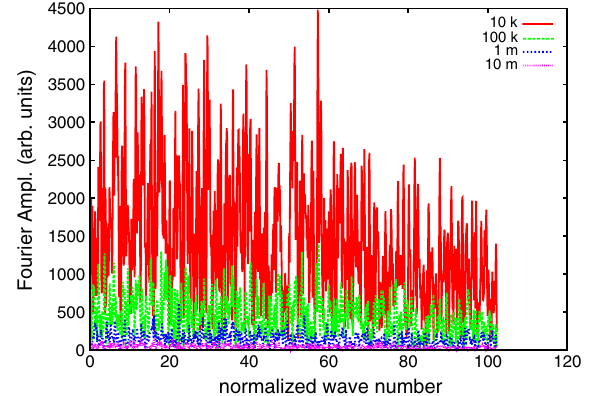
FIG. 2. A schematic diagram of the layout of the next gen- eration high repetition rate